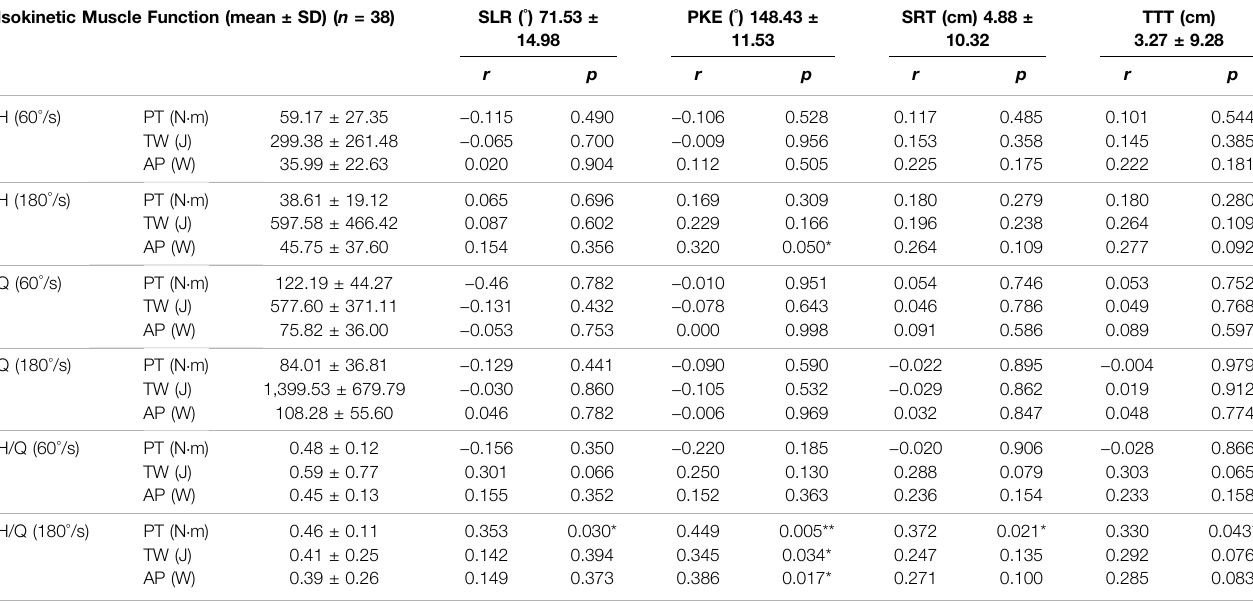
TABLE 3 | Relationship between hamstring fl exibility measured with 4 common tests and the isokinetic function of thigh muscles. Isokinetic Muscle Function (mean ± SD) ( n =